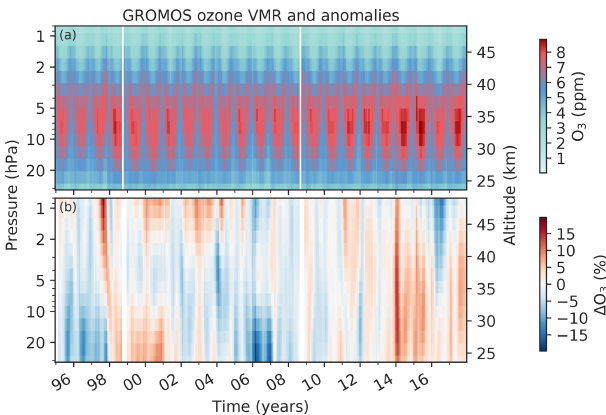
Figure 1. (a) Monthly means of ozone volume mixing ratio (VMR) measured by GROMOS (Ground-based Millimetre-wave Ozone Spectrometer) at Bern from January 1995 to December 2017. The white lines indicate months for which no measurements were avail- able due to instrumental issues. (b) Deviation from GROMOS monthly mean climatology (1997 to 2017), smoothed by a moving median window of 3